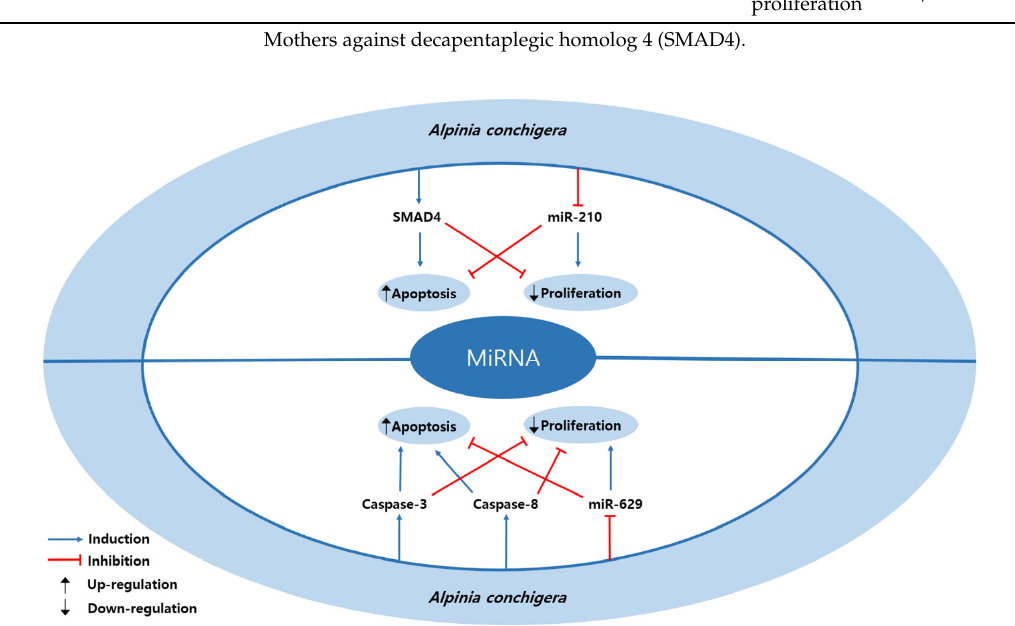
Figure 5. Schematic diagram of miRNAs regulated by natural products in cervical